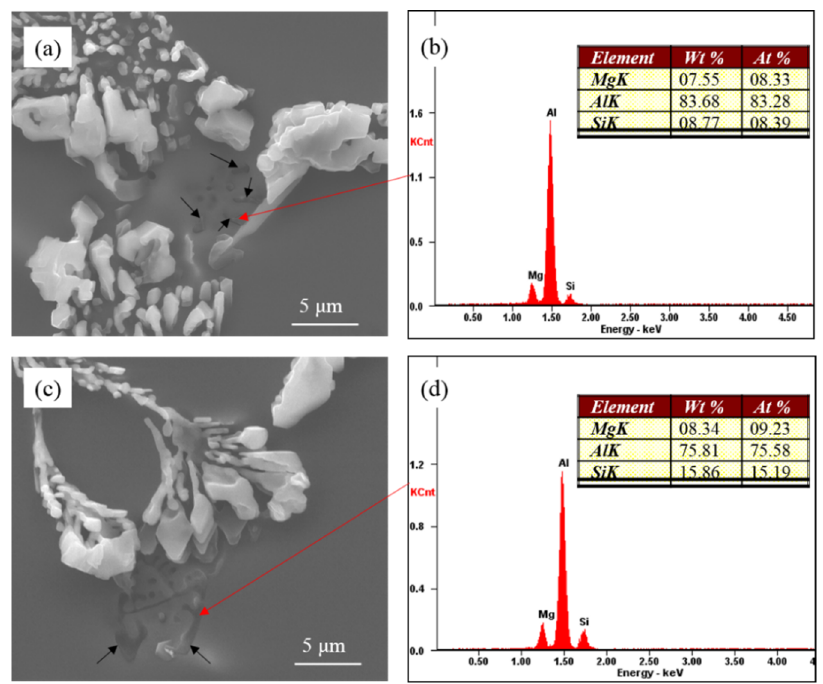
Figure 8. Morphology of partially modified eutectic Si and Mg-rich phase in high pure Al-7Si-0.4Mg alloy; ( a ) modified by Na; ( c ) modified by Sr; ( b , d ) Corresponding EDS results. It becomes clear that the eutectic silicon exhibited incomplete modification in Al-7Si- 0.4Mg alloy for both Na modification and Sr modification. There is a close